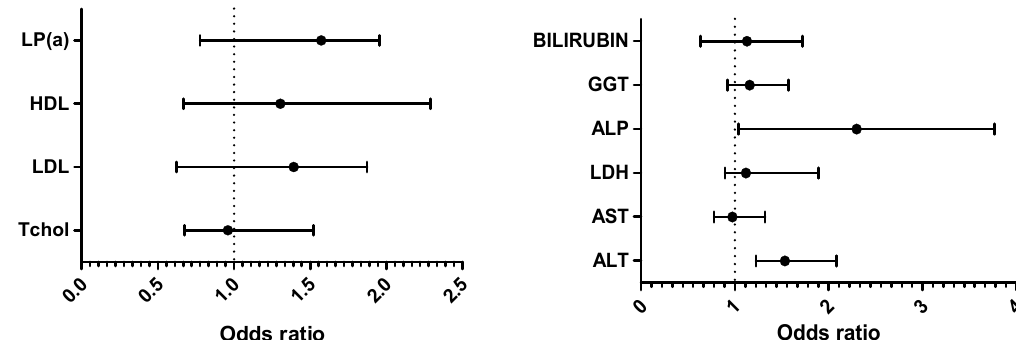
Figure 2. Binomial logistic regression (BLR) of all the biochemical parameters: Exposed Pakistan vs. exposed Cameroon (Tchosl = total cholesterol; HDL = high density lipoprotein; LDL = low density lipoprotein; Lp(a) = Lipoparticule a; AI = Arterogenic Index; BUN = Blood urea nitrogen; AST = aspartate transaminase; ALT = alanine transaminase; LDH = lactate deshydrogenase; GGT = gamma-glutamyl transferase; ALP = alkalin phosphatase; DBil = direct bilirubin; TBil = total bilirubin).